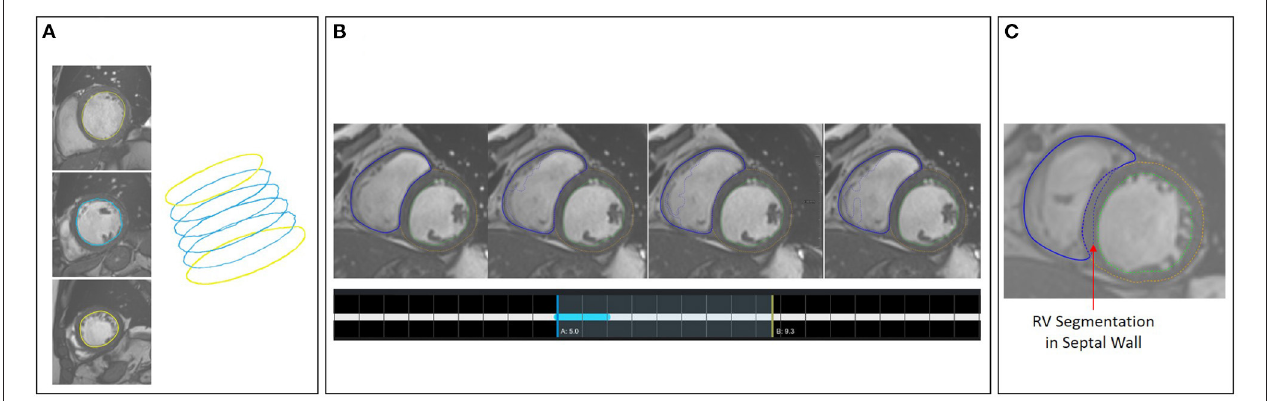
FIGURE 6 | (A) Shape-based interpolation: manual contours (yellow) are defined on two slices. The blue contours represent the interpolated results. (B) Temporal correction: top row shows a series of time frames of a cine MRI dataset. The solid contour shows the manually corrected contours. The dotted contours represent the incorrect segmentation results. The time-point widgets show the range the user selected for correction via contour propagation. (C) Correction with logical conditions: the contour of the right endocardium was originally drawn into the septal wall (blue dotted contour). The solid contour represents the corrected